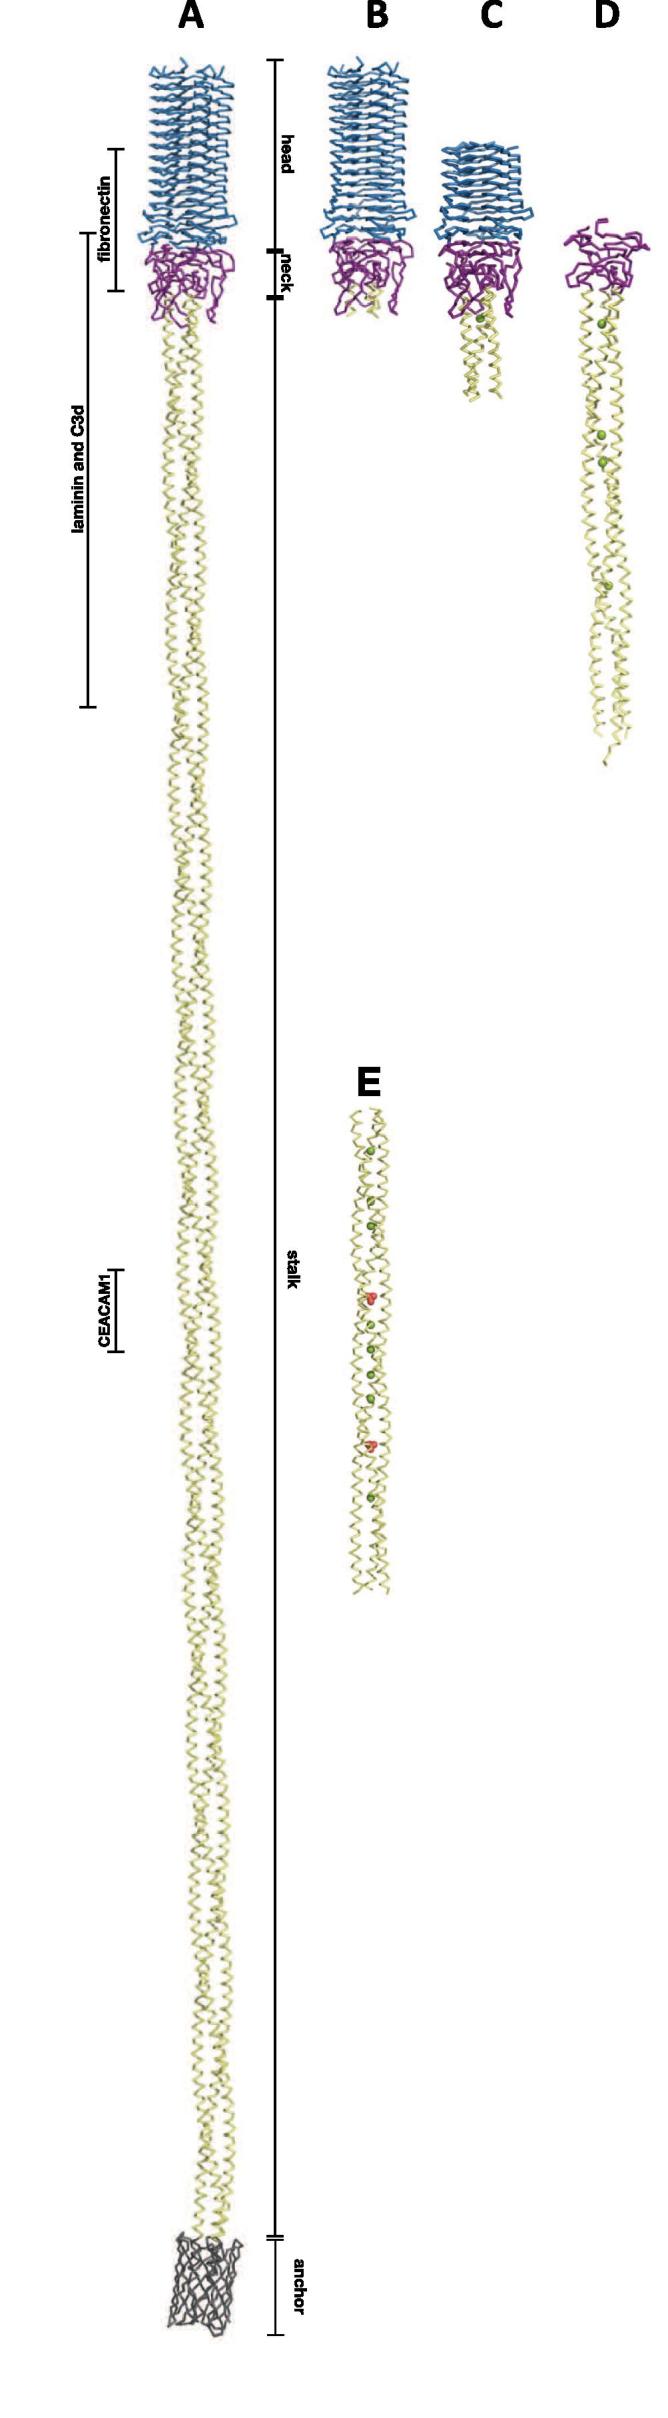
Comparison of UspA1 structures from Moraxella catarrhalis. (A) Modelled structure of full-length UspA1 with four differently coloured and labelled regions, starting from N-terminus: head (blue), neck (purple), coiled-coil stalk (yellow) and trans-membrane β-barrel (grey). Sites for ligand binding marked on the left-hand side: fibronectin (165–318), laminin and C3d (299–452), CEACAM1 (578–597). Structures of different solved UspA1 fragments (B) UspA142–345 (3PR7) (Agnew et al., 2011); (C) UspA1153–366 (3NTN) (Agnew et al., 2011); (D) UspA1299–452 (6QP4) solved in this study; (E) UspA1527–665 (2QIH) (Conners et al., 2008); Cl− ions in green and PO43− in red.